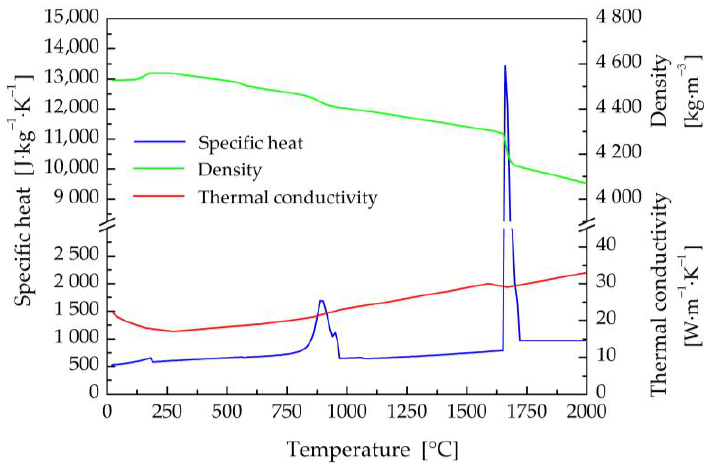
Figure 2. Thermal properties of Ti Grade 2 in dependence on temperature.